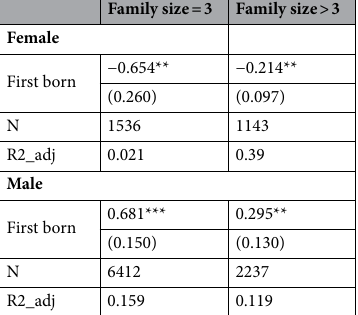
Table 4. the effects of birth order on the education of female and male, separate regression by family size.